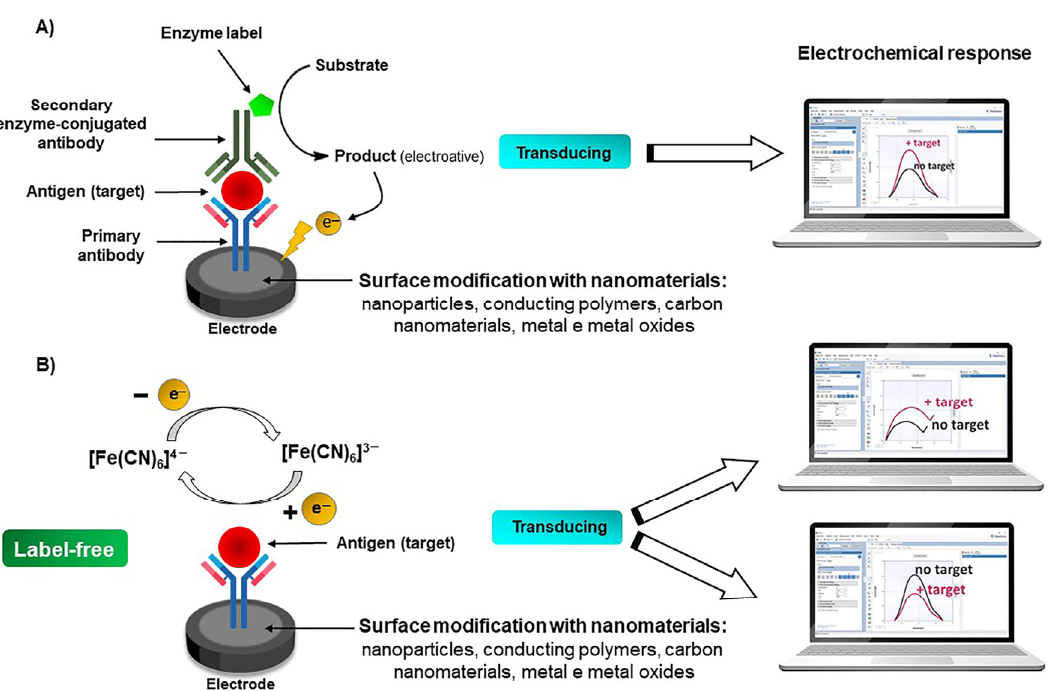
Scheme 1. General representation of the main components of an electrochemical immunosensor. The scheme describes a generic immunosensor based on indirect ( A ) and direct ( B )